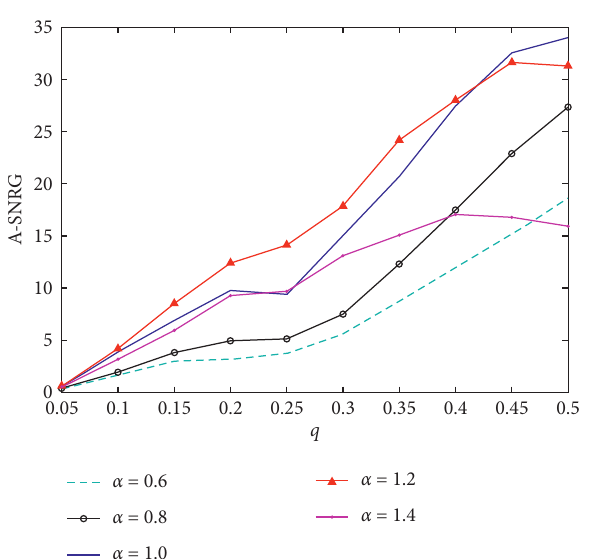
Figure 9: A-SNRG of SR with asymmetric width of potential well as a function of noise intensive D for asymmetric factor with different values of α